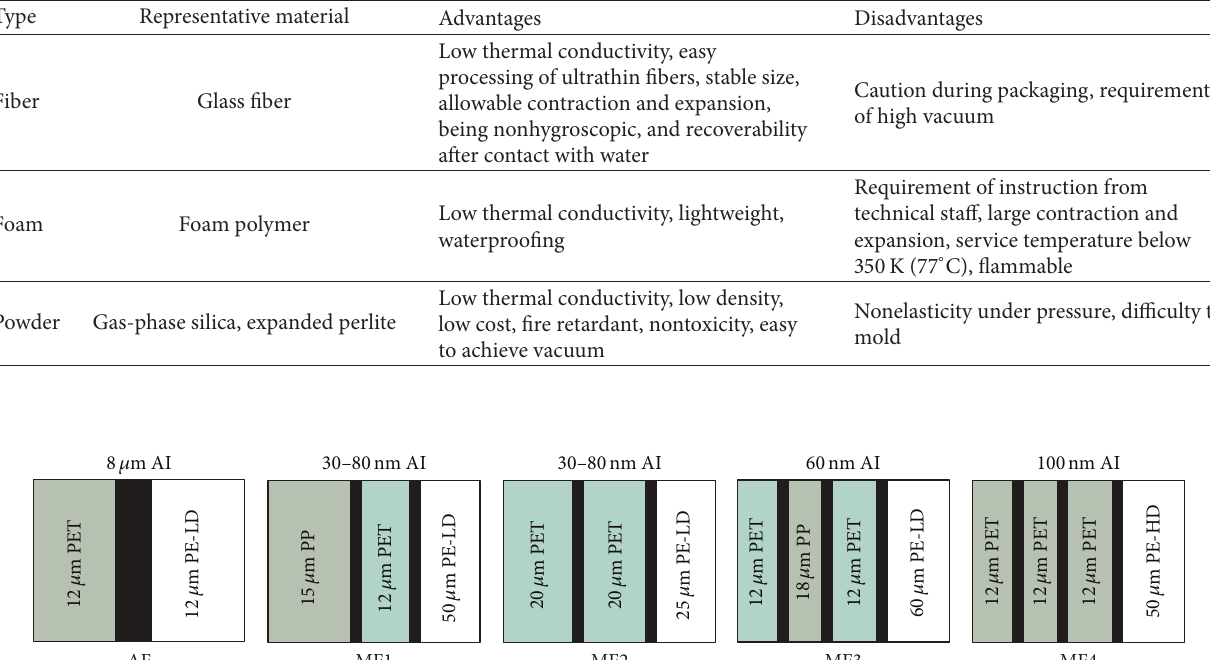
Table 1: Characteristics of different core materials.